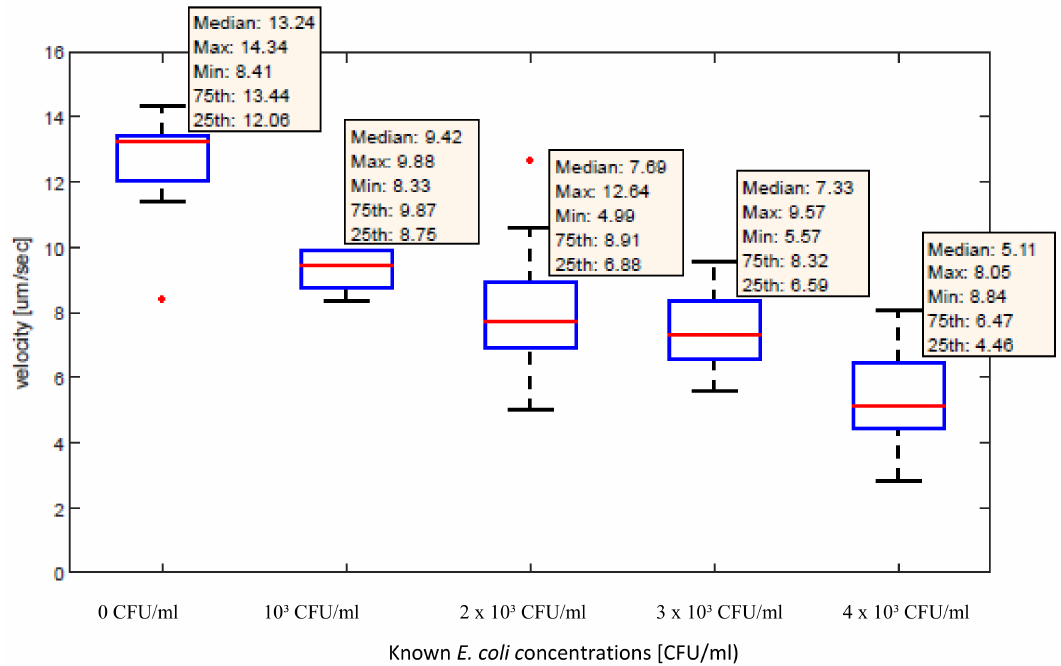
Figure 12. The velocities of the manipulated MPs and MLBs for different E. coli